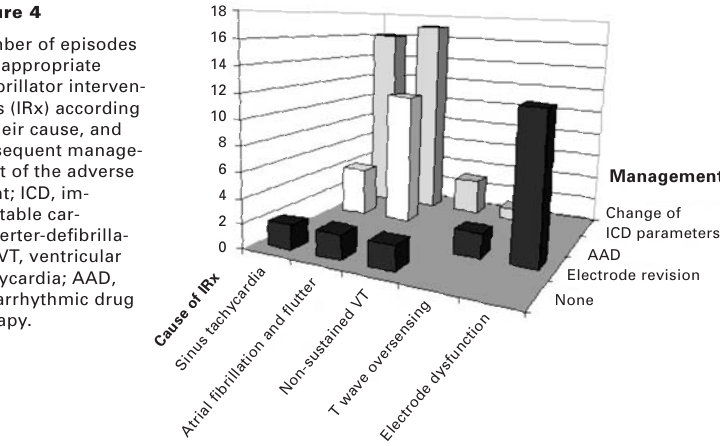
Number of episodes of inappropriate defibrillator interven- tions (IRx) according to their cause, and subsequent manage- ment of the adverse event; ICD, im- plantable car- dioverter-defibrilla- tor; VT, ventricular tachycardia; AAD, antiarrhythmic drug